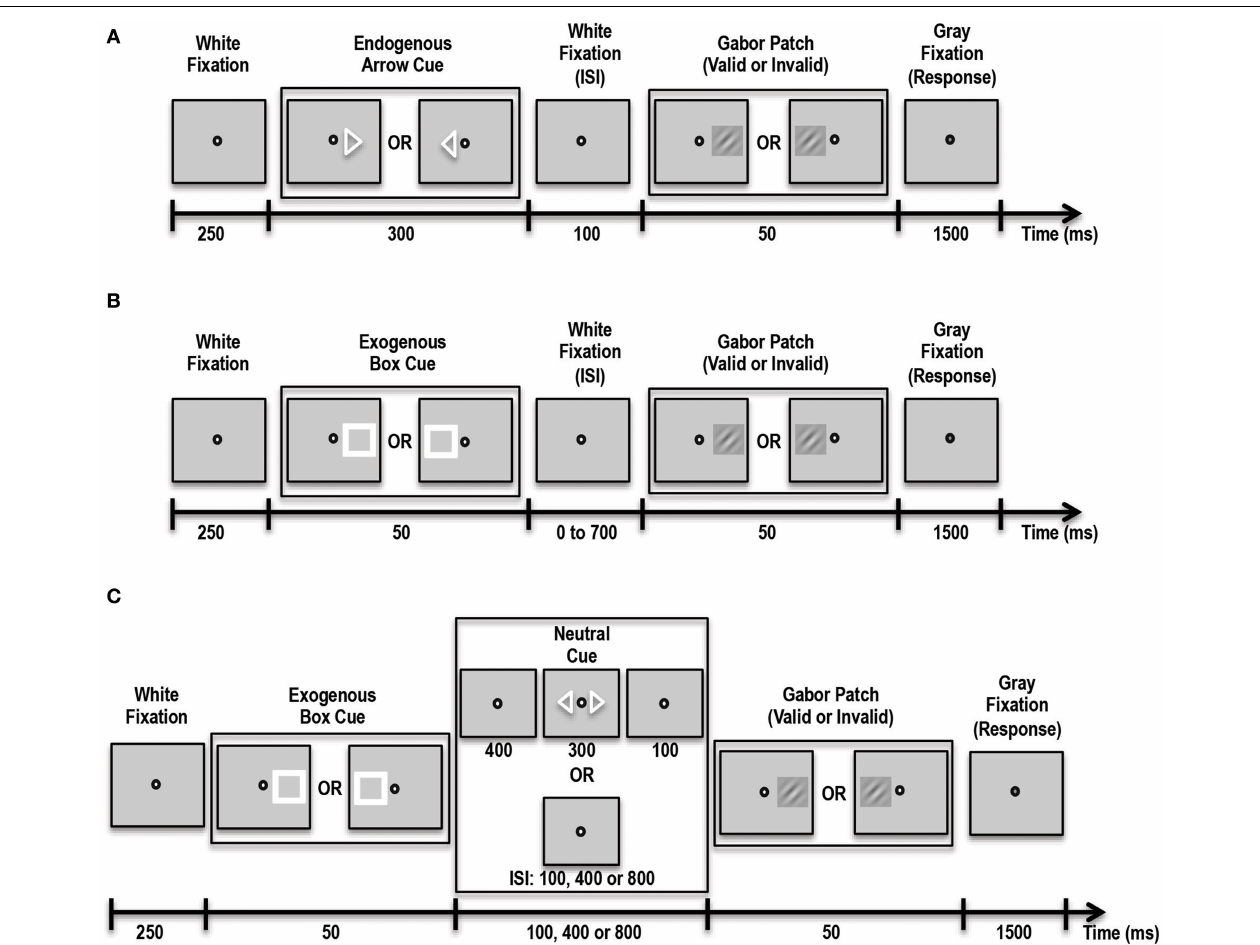
FIGURE 2 | Schematic showing the various tasks administered to patient and controls. (A) Schematic of the Endogenous Cueing Task. (B) Schematic of the Exogenous Cueing Task. (C) Schematic of the Exogenous Cueing Task with Explicit Reorienting. ISI, Inter-stimulus Interval is the time between the cue and stimulus. ISI for the